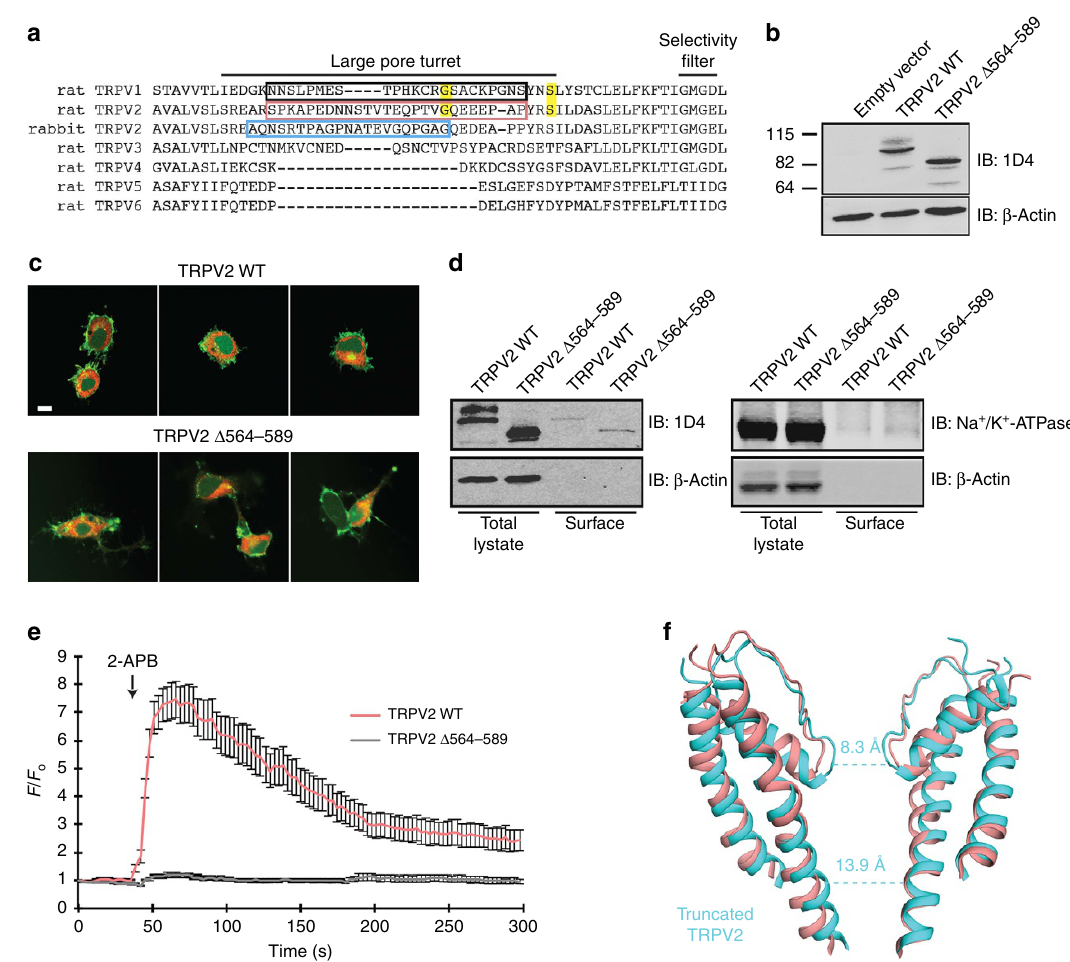
Figure 4 | Large-pore turret may influence the TRPV2 ion permeation pathway. ( a ) Sequence alignment of the pore turret region of the TRPV family members. Black and cyan box highlight the truncated pore turret pore region in the ‘minimal’ TRPV1 and truncated rabbit TRPV2 proteins used for structure determination, respectively. The salmon box highlights the corresponding region truncated in the TRPV2 protein (TRPV2 D 564–589) for this analysis. ( b ) Western blot analysis of F11 cells transfected with empty vector, 1D4-tagged TRPV2 WTor 1D4-tagged TRPV2 D 564–589 using indicated antibodies. ( c ) F11 cells were co-transfected with plasma membrane-GFP (GFP-labelled palmitoylation sequence from GAP43; green) and either 1D4-tagged TRPV2 WTor TRPV2 D 564–589. Cells were fixed and immunostained using anti-1D4 antibody (red). Scale bar, 10 m m. ( d ) Surface biotinylation analysis of F11 cells transiently expressing either 1D4-tagged TRPV2 WTor TRPV2 D 564–589. Proteins were visualized by western blot analysis using the indicated antibodies. ( e ) Intracellular calcium response of F11 cells transfected with TRPV2 WT (blue; n ¼ 50) or TRPV2 D 564–589 (red; n ¼ 59) was recorded by Fluo4 fluorescence in response to 100 m M 2-APB. Cells were treated with 2-APB at the 45-s time point (indicated by arrow). Data represent the normalized mean Fluo4 intensity. ( f ) Atomic model of the S5–P–S6 region of truncated rabbit TRPV2 superimposed onto the same region of full-length rat TRPV2. Two subunits are shown for clarity. The dotted lines show the C a –C a distances in the truncated rabbit TRPV2 structure, which represents the upper and lower